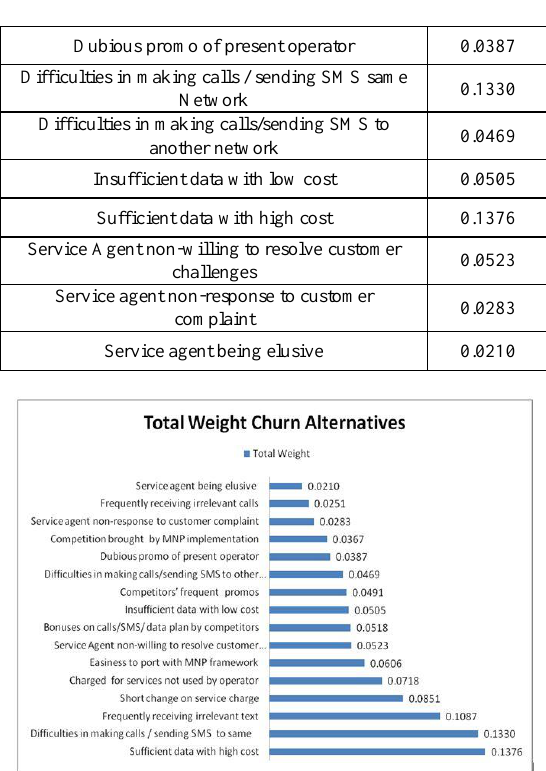
Figure 4.1. Horizontal bar chart of the total weight of customers` churn alternatives